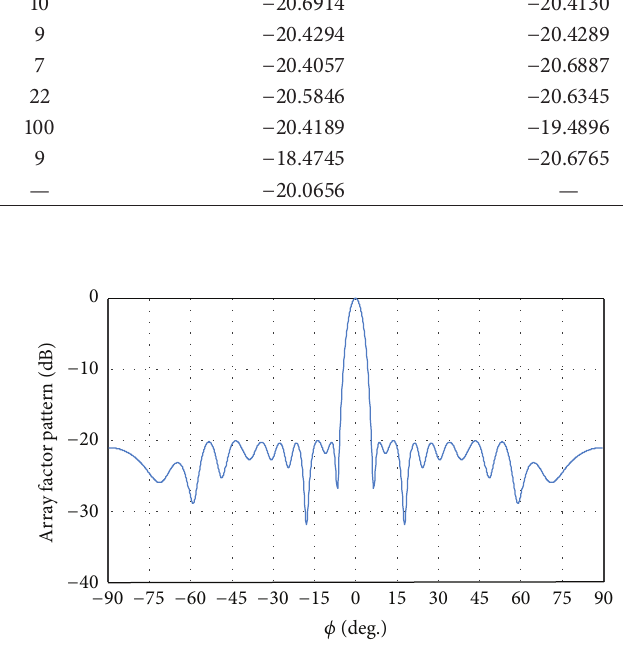
Figure 5: The synthesized radiation pattern with optimally minimal array elements (16 elements) under real weight coefficient